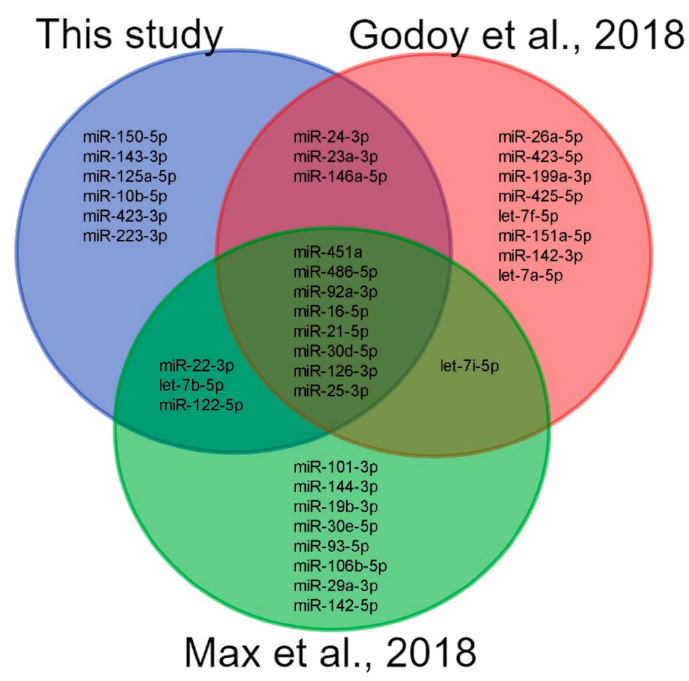
Figure 15. Venn diagram showing the overlapping between the top 20 miRNA species lists from this study and two previous studies using small RNA sequencing to explore circulating plasma miRNA profiles in the groups of healthy adults. This study: 30 samples from 10 individuals; Godoy et al. [49]: 12 samples from 12 individuals; Max et al. [51]: 159 samples with more than 0.5M miRNA reads from 13